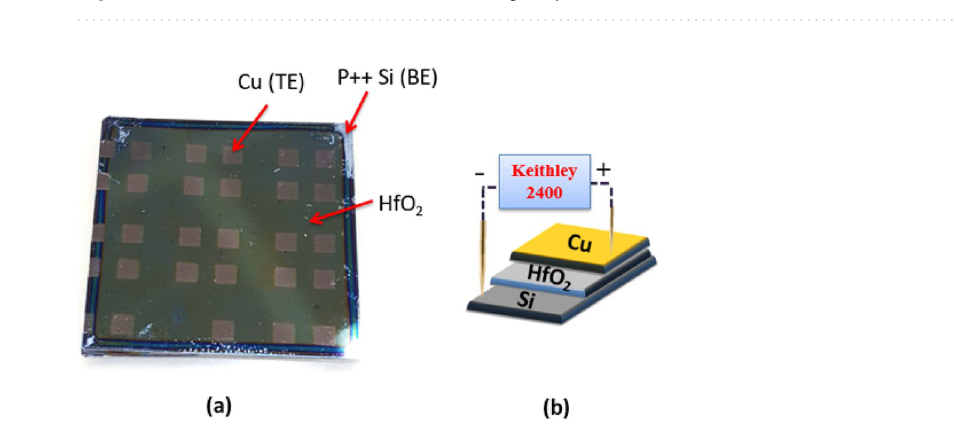
Figure 2. I–V characteristic of memristor during 1 Cycle (SET/RESET).